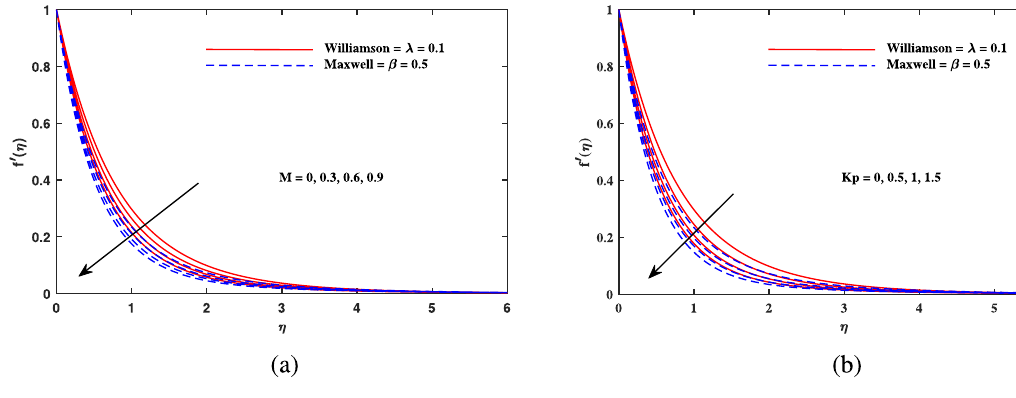
Figure 2. Velocity f ′ (η) fluctuation with ( a ) M and ( b ) K p .